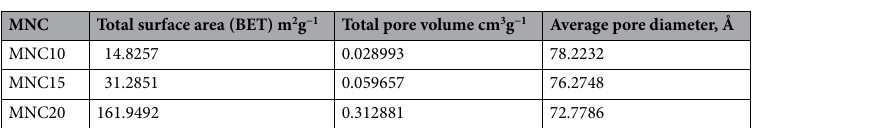
Table 1. SBET parameters for different